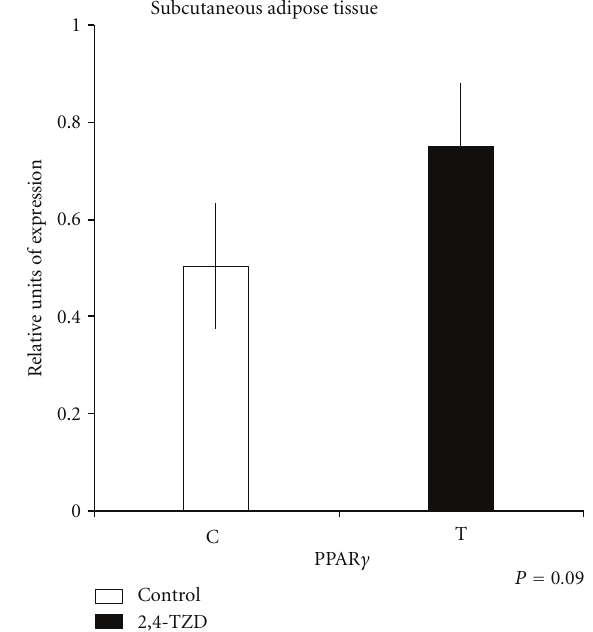
Figure 3: Quantitative polymerase chain reaction (qPCR) of per- oxisome proliferation-activated receptor (PPAR) γ in subcutaneous (SC) adipose tissue. Columns show relative expression of PPAR γ in Control (C) and Thiazolidinedione (TDZ) (T)